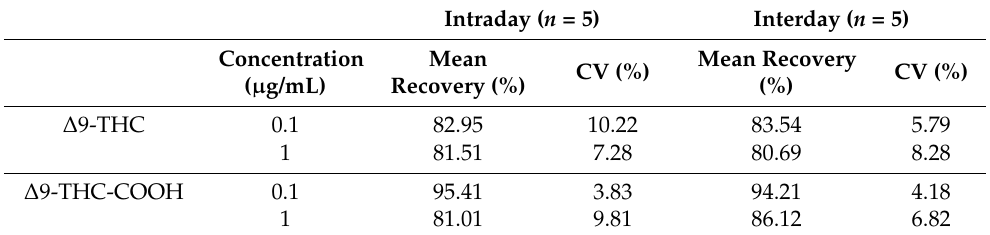
Table 3. Recovery data obtained for ∆ 9-THC and ∆